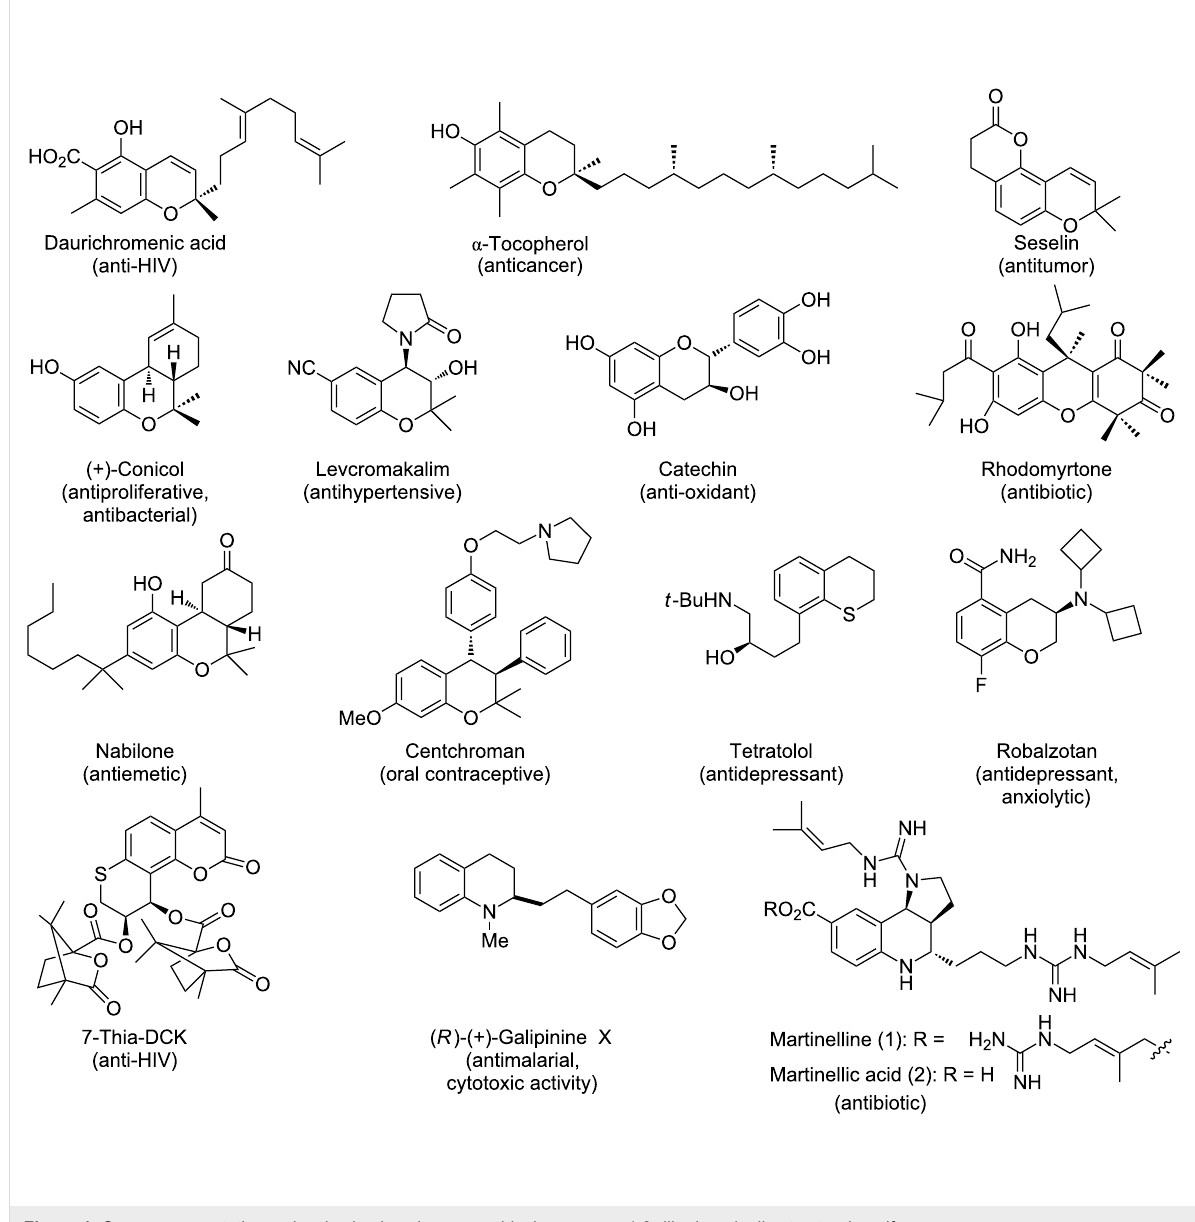
Figure 1: Some representative molecules having chromene, thiochromene or 1,2-dihydroquinolin structural